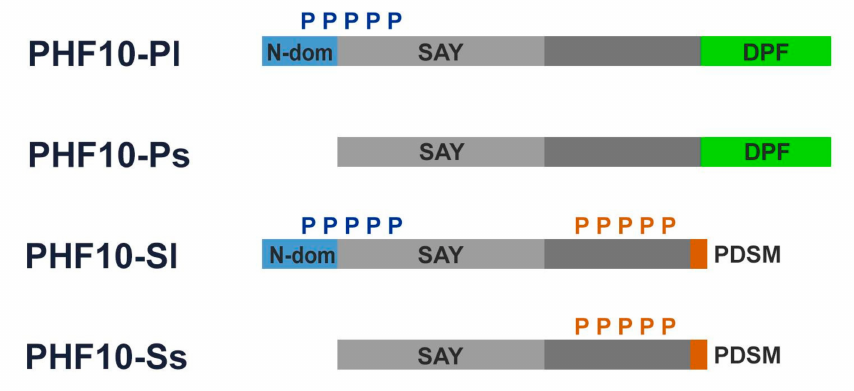
Figure 1. PHF10 relative expression in different metacells in a mouse embryo during gastrulation. Meta-cell is a transcriptional state shared by cells from numerous embryos, spanning a specific time range. Scale: log2-fold change (relative to mean expression over all metacells). Data source: [20].